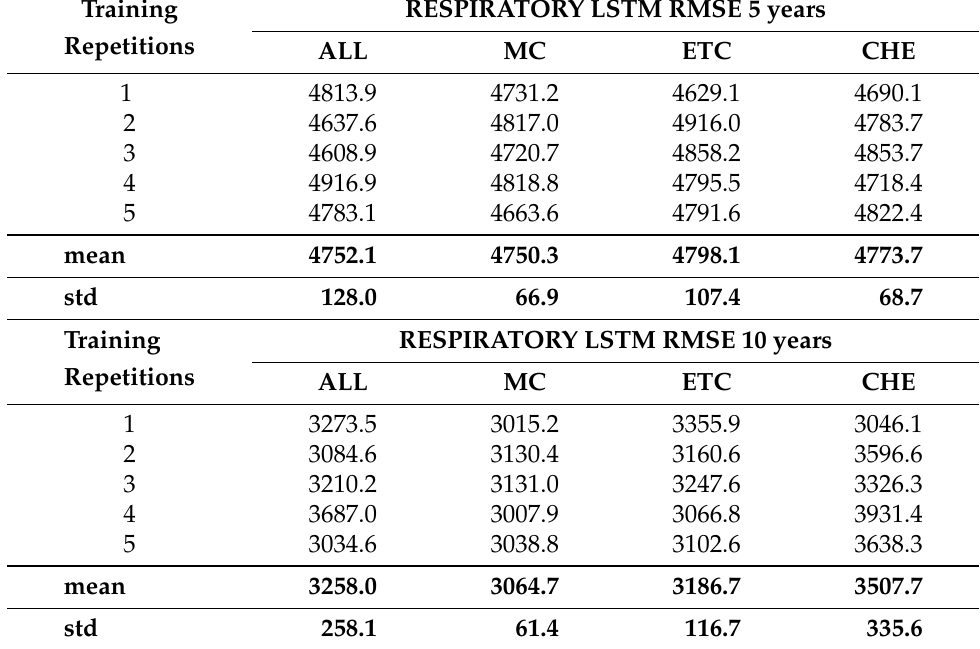
Table 7. Respiratory RMSE using 5 and 10 years